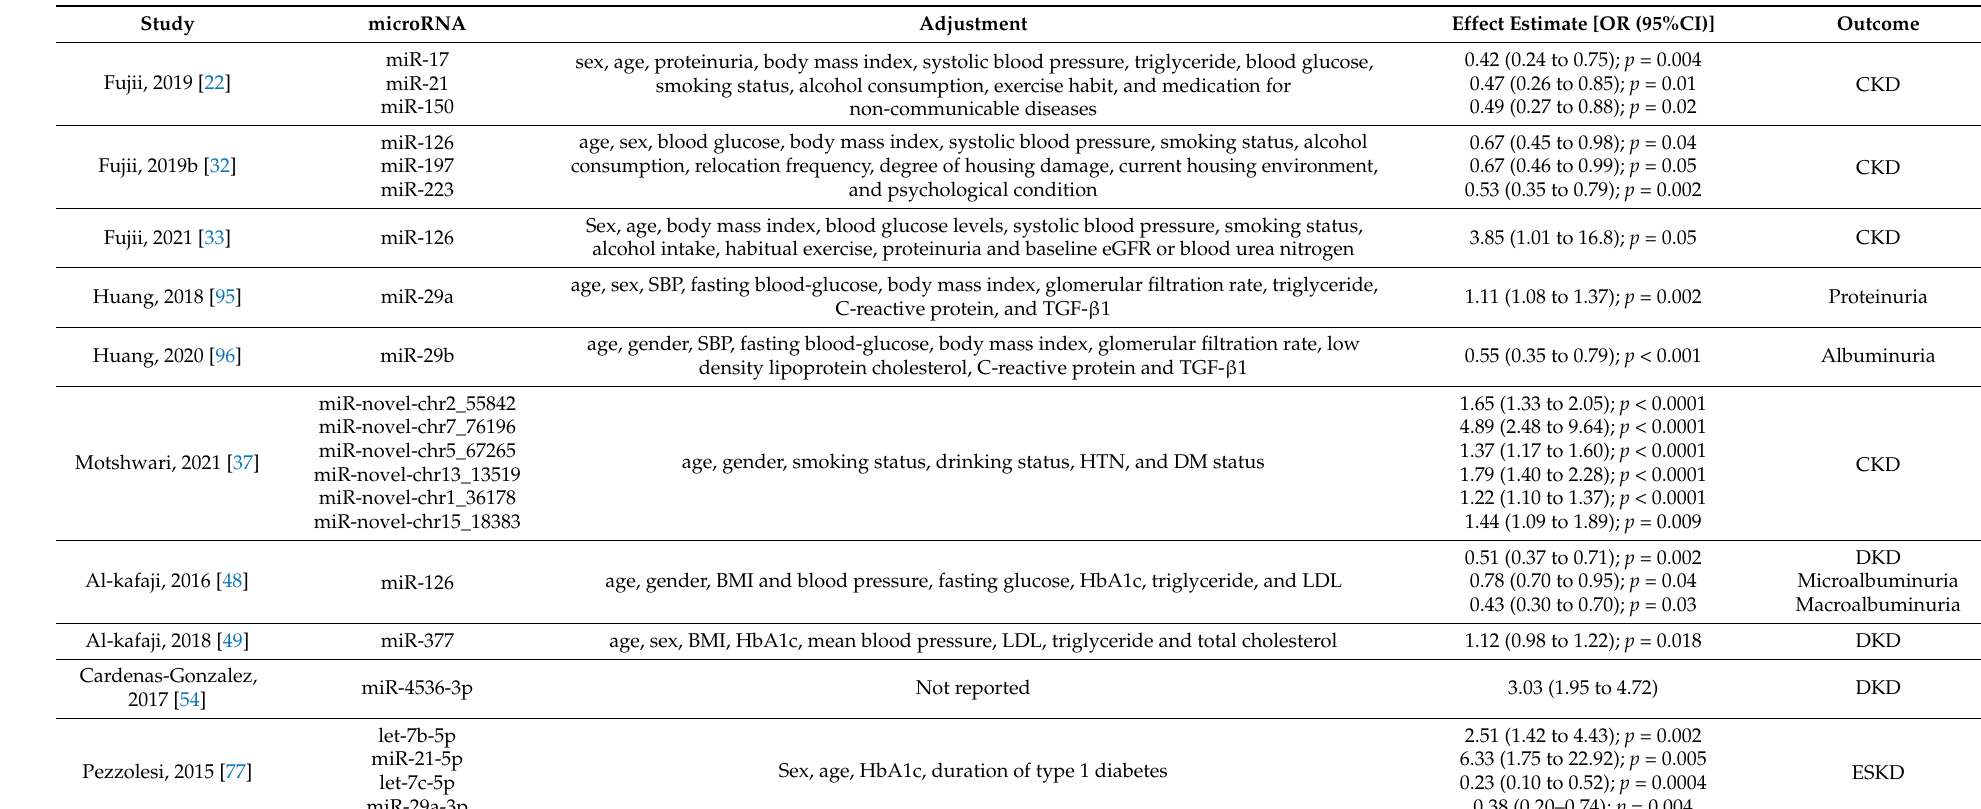
Table 5. Association of miRNAs with kidney disease